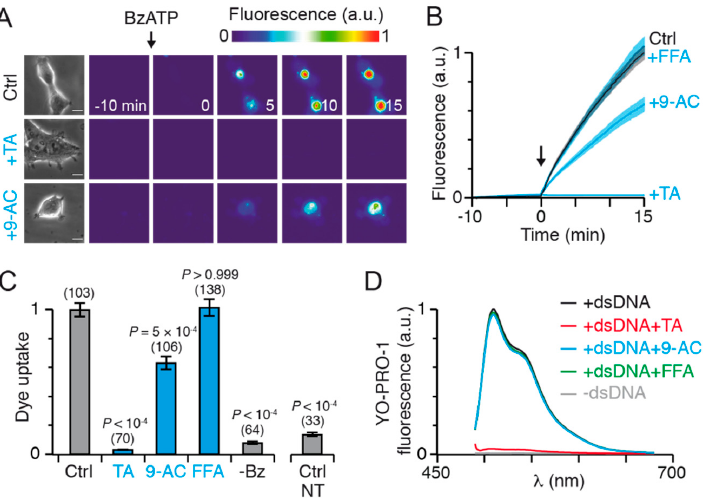
Figure 4. Effects of CaCC inhibitors on dye uptake. ( A ) Time series fluorescence images of YO-PRO-1 dye uptake in HEK293T cells transiently expressing rP2X7, in the absence or presence of inhibitors, as indicated. Fluorescence (in arbitrary units) was acquired at indicated times before and after 10 μ M BzATP (arrow) application, which begins at 0 min. Inhibitors were co-applied at the same time as BzATP. On the left are shown the corresponding microphotographs under transmitted light (scale bar, 10 μ m). ( B ) Corresponding YO-PRO-1 dye uptake over time upon BzATP activation (arrow) in the absence or presence of inhibitors, as indicated. Solid lines represent mean ± SEM (shaded areas). ( C ) Summary of BzATP-induced YO-PRO-1 dye uptake normalized to rP2X7-transfected cells in the absence (Ctrl, grey histogram) or presence of inhibitors (blue histograms). Numbers of cells are indicated above bars. Dye uptake in the absence of BzATP is labelled -Bz. BzATP-induced dye uptake in non-transfected cells (NT) was normalized to another set of rP2X7-transfected control ( n = 78 cells). Bars represent mean ± SEM (from 3 to 12 transfections). p values are from one-way Kruskal-Wallis ANOVA followed by Dunn’s comparison to respective controls. ( D ) Fluorescence spectra of 10 μ M YO-PRO-1 bound to double strand DNA (dsDNA) recorded before (black trace, averaged from respective controls) and immediately after application of TA (red), 9-AC (blue) or FFA (green). Fluorescence spectra of 10 μ M unbound YO-PRO-1 (in the absence of dsDNA) is indicated in grey. CaCC inhibitor concentrations were 20 μ M TA, 1 mM 9-AC and 100 μ M FFA. No dye uptake was observed in the absence of BzATP or in its presence in non-transfected cells (Figure 4C). TA co-applied with BzATP abolished dye uptake, but curiously, the extent of inhibition was greater than that of controls (i.e., without BzATP or in non-transfected cells) (Figure 4A–C). This suggests that TA, in addition to its dye uptake inhibition, may quench YO-PRO-1 fluorescence before dye uptake. To test this hypothesis, we acquired emission spectra of YO-PRO-1 bound to double strand DNA (dsDNA) in the absence or presence of TA and found that addition of TA led to immediate and complete quenching of fluorescence intensity (Figure 4D). In contrast, no fluorescence quenching was observed with 9-AC or FFA (Figure 4D), even 15 min after inhibitor addition. These data demonstrate that TA is a powerful YO-PRO-1 quencher, and therefore should not be used as a pharmacological inhibitor in dye uptake assays. Next, we found that 9-AC significantly reduced BzATP-stimulated YO-PRO-1 uptake, by ~40% while no dye uptake inhibition was observed with FFA (Figure 4A–C). These results suggest that the functional interaction between P2X7 and TMEM16 contributes partially to dye uptake. Because TMEM16F was previously shown to mediate functional effects downstream of P2X7 [30], we tested the hypothesis that the functional interaction between P2X7 and TMEM16 features the hTMEM16F subtype.